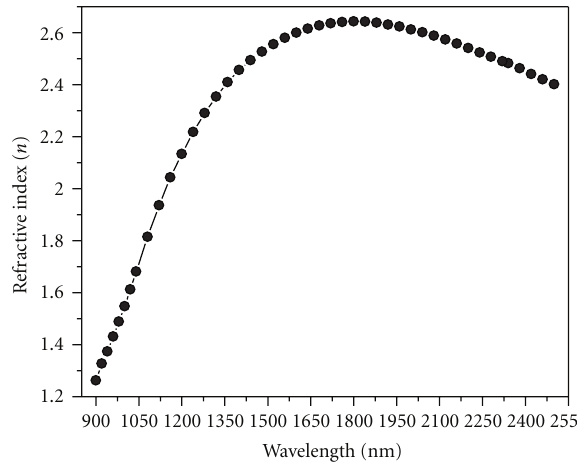
Figure 8: Spectral distribution of the refractive index of PbTe thin